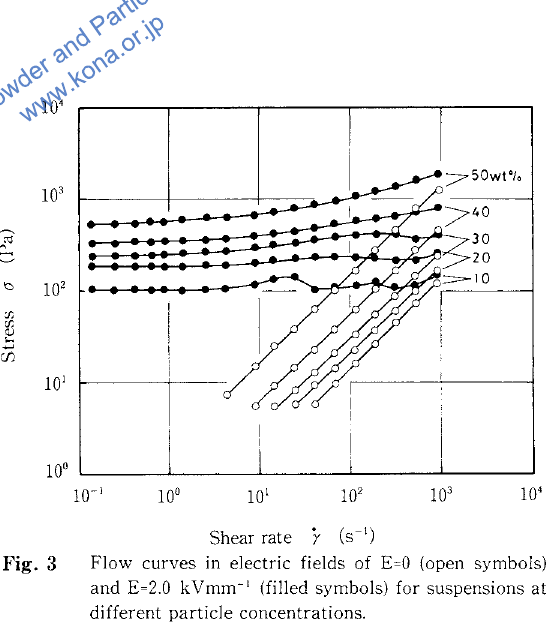
Fig. 3 Flow curves in electric fields of EoO (open symbols) and Eo2.0 kVmm- 1 (filled symbols) for suspensions at different particle